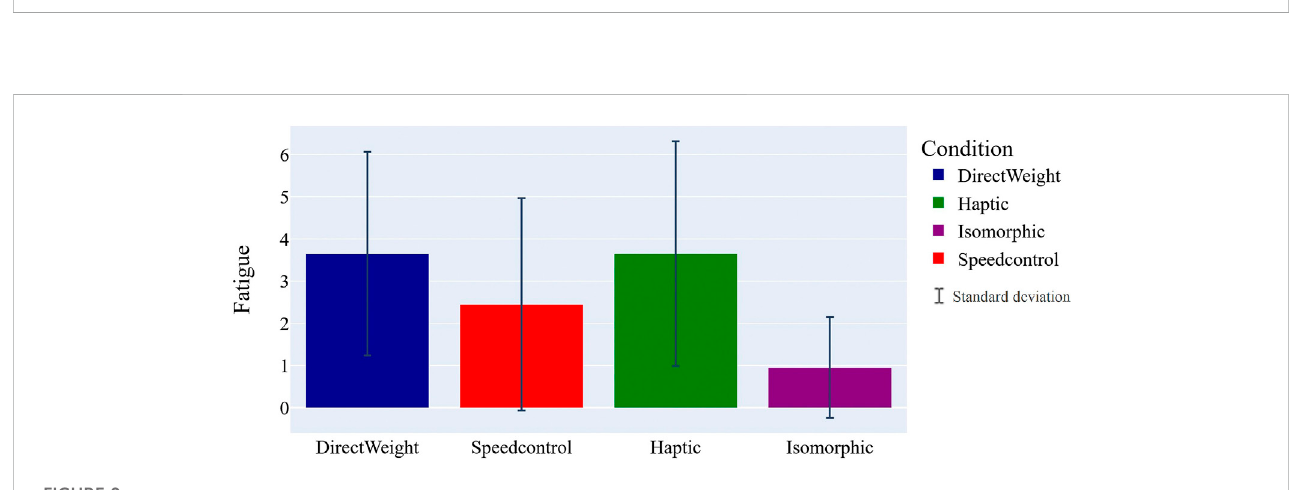
FIGURE 8 Differences between different users ’ behaviors in haptic and non-haptic conditions. (A) Individual values (dots) and mean values (bar plot) of work in different conditions in VR for different masses. (B) Individual and mean values of “ physical work ” (bar plot) in reference conditions (haptic). Data are shown as mean ± SD. Gary lines present users ’ behavior trends for different masses.